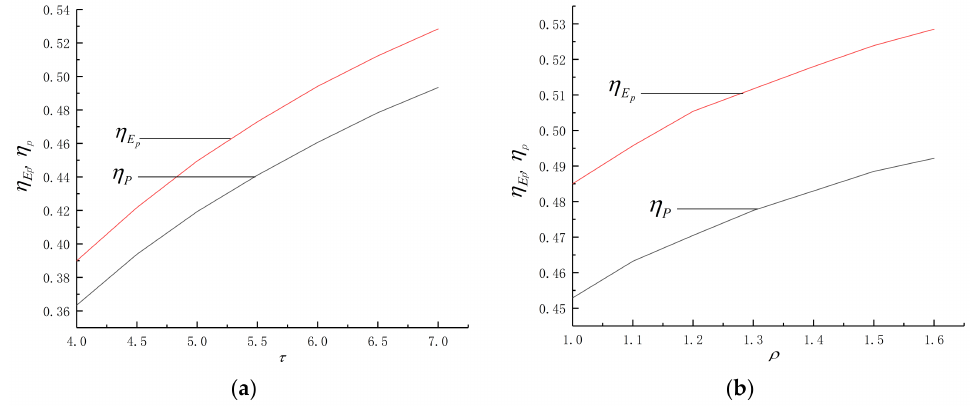
Figure 5. Effects of τ and ρ on η E